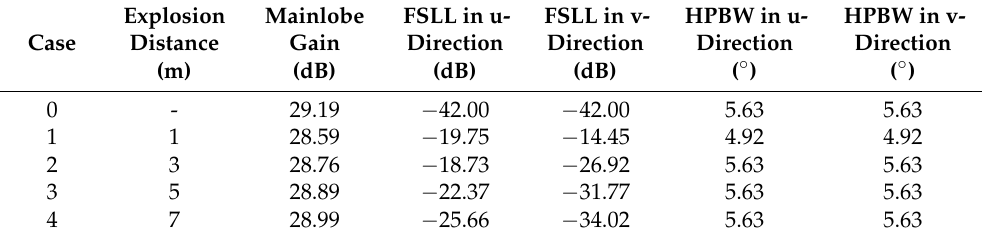
Table 7. Electrical performance parameters at different explosion distances in the receiving mode.